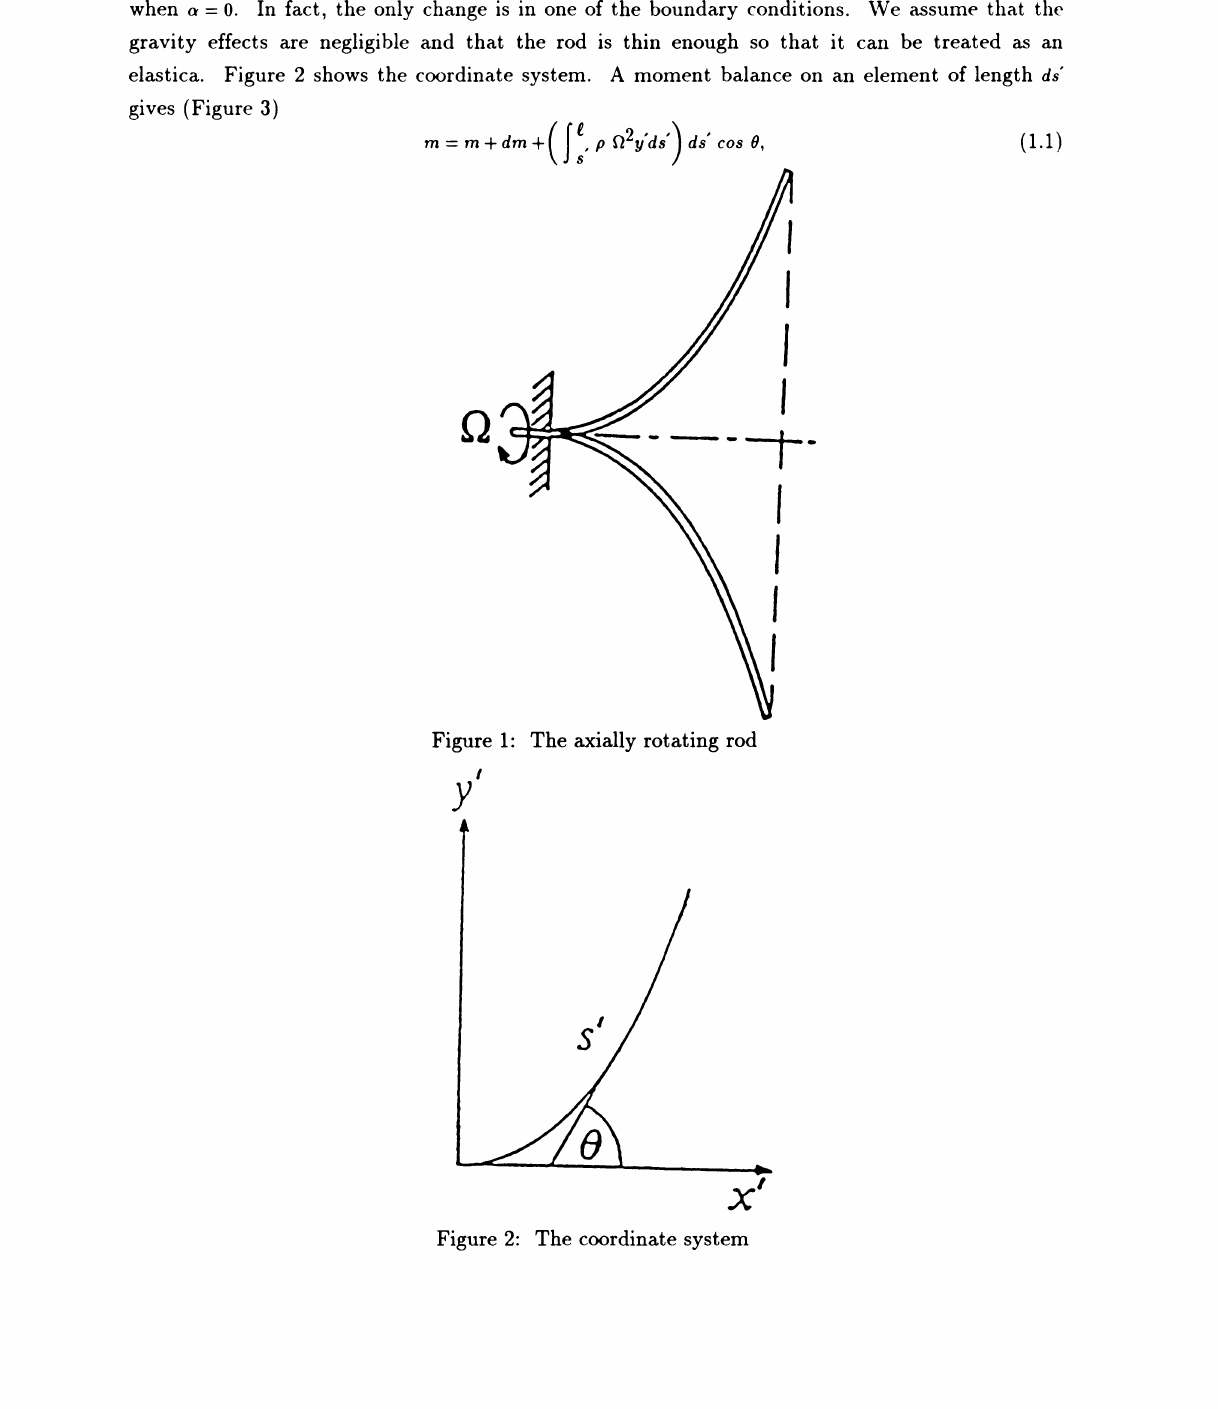
Figure 2: The coordinate